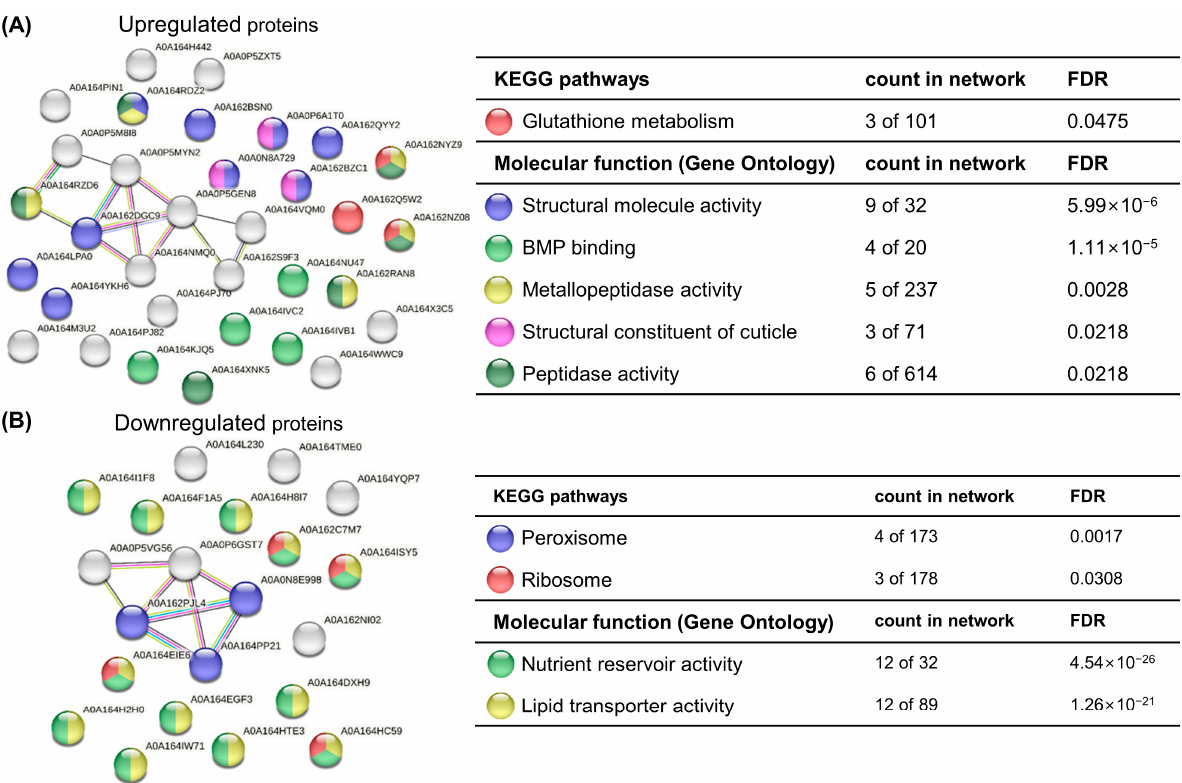
Figure 4. Protein–protein interaction networks and functional enrichments of differentially expressed proteins (DEPs) in D. magna after exposure to EC 20 CMIT/MIT: KEGG pathways and GO molecular functions were enriched among ( A ) upregulated proteins and ( B ) downregulated proteins.